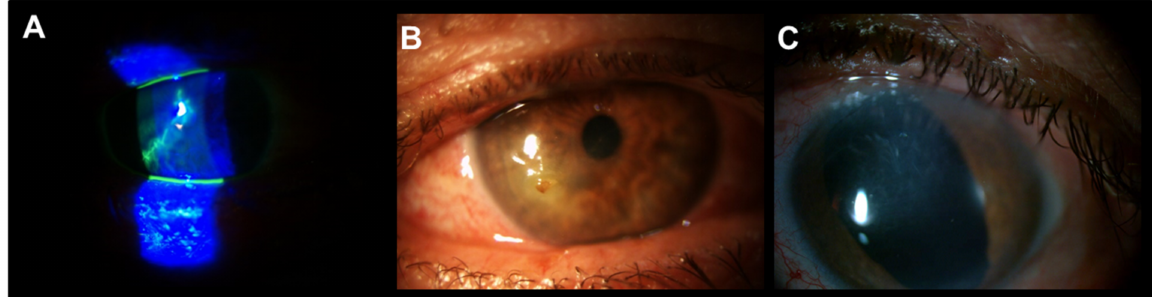
Figure 4. Patient with meta-herpetic corneal ulcer treated with PRGF and RGTA. ( A ): Baseline image. ( B ): Acute post- infection neurotrophic corneal ulcer. ( C ): Complete corneal ulcer closure after two cycles of PRGF eye drops. The corneal closure was stable throughout the follow-up (38.3